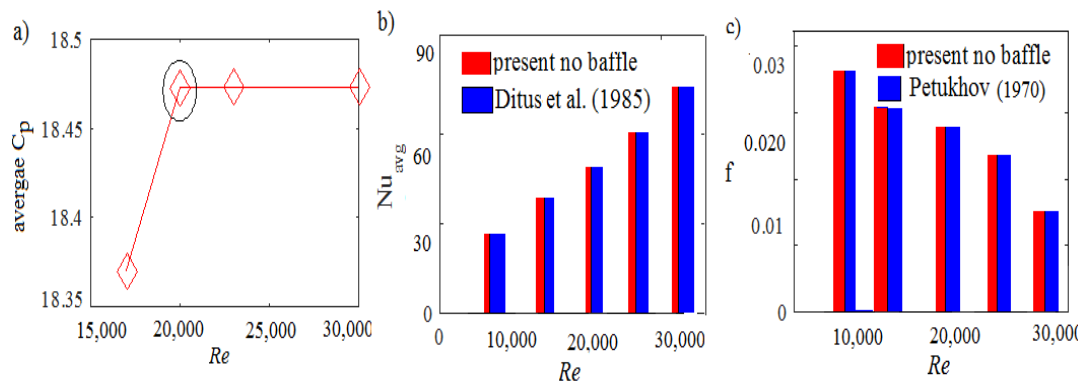
Figure 2. Profiles of average C p , Nu avg and f with Re .